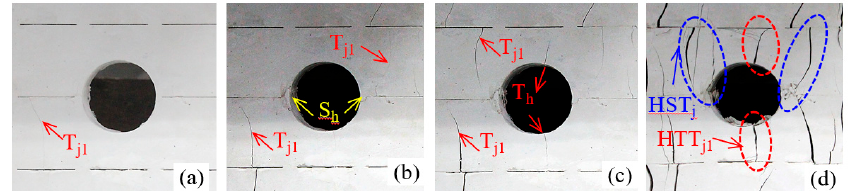
Figure 10. Cracking process around the hole in specimen HD0 of collapse mode II h : ( a ) σ 1 = 0.81 σ p , ε 1 = 0.75 ε p ; ( b ) σ 1 = 0.95 σ p , ε 1 = 0.95 ε p ; ( c ) σ 1 = 0.59 σ p , ε 1 = 1.33 ε p, and ( d ) σ 1 = 0.56 σ p , ε 1 = 3.23 ε p .